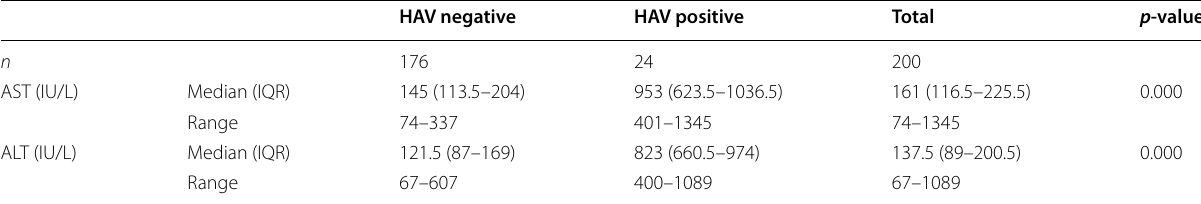
Table 4 Liver enzymes of HAV‑negative and HAV‑positive